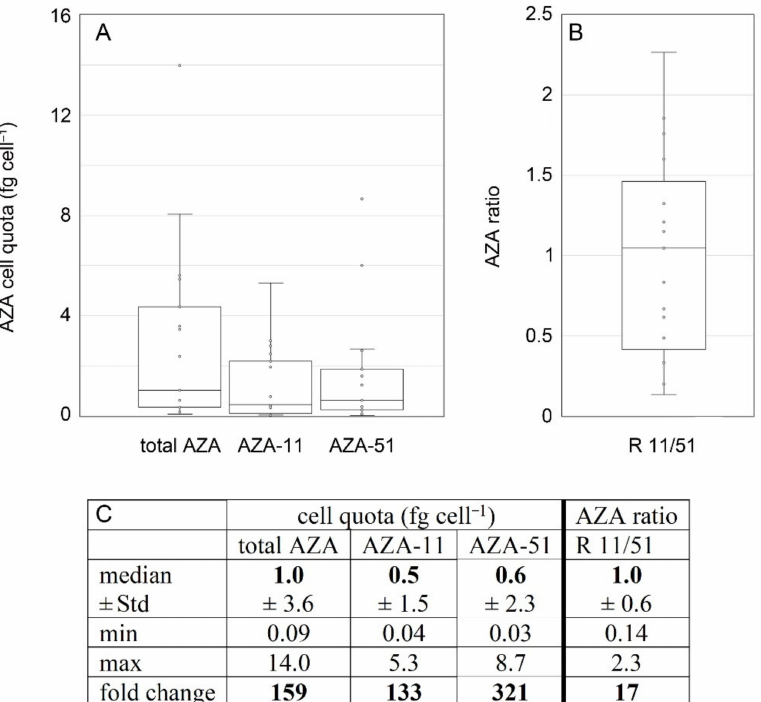
Figure 11. Azadinium spinosum ribotype B strains. Box and Whisker plots ( A , B ) and summary statistics ( C ) of all analyses (including repeated analyses of single strains) of AZA cell quota ( A ) and AZA ratio ( B ). Std = standard deviation.